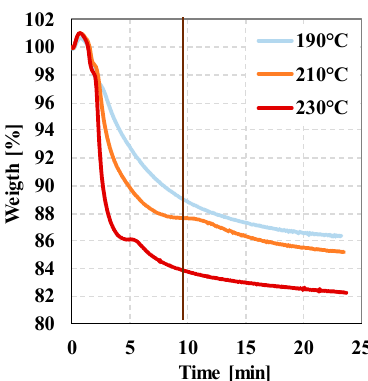
Figure 3. TGA (Thermogravimetric analysis) curves of expandable microspheres (from 10 min the measurement temperature is isothermal) weight loss as a function of temperature.